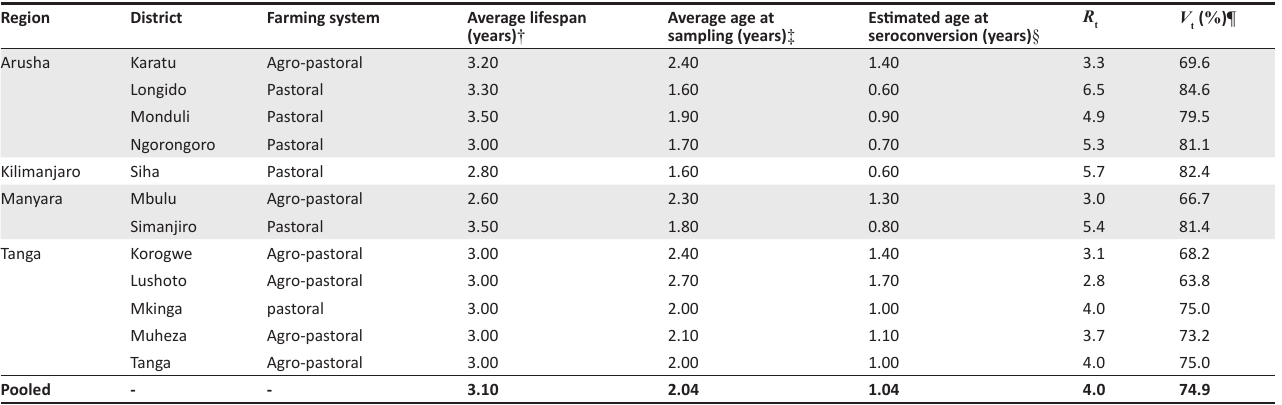
TABLE 3a: Estimation of effective reproductive number for peste des petits ruminants virus infection of pastoral sheep and goat flocks in Tanzania, using average lifespan and age indices. Region District